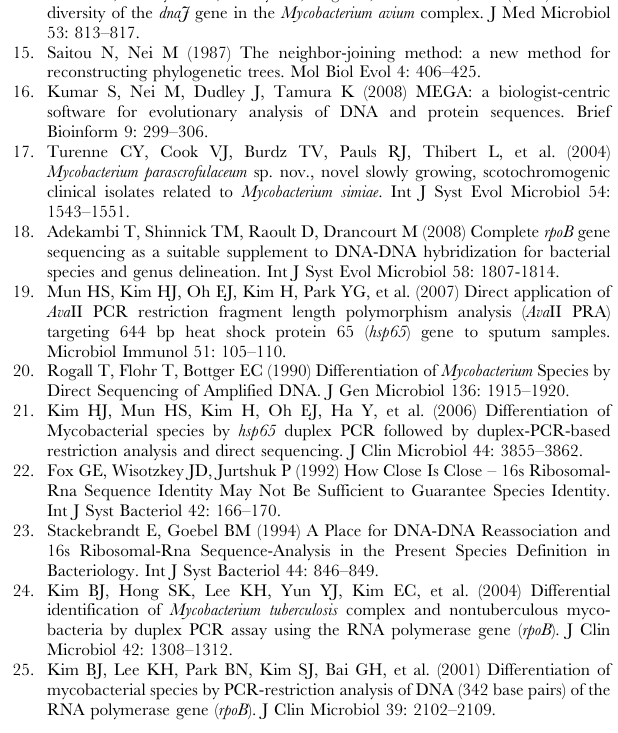
Figure S1 Locations of primers used for amplification of the full rpoB ( 3450 bp ) gene sequence in this study. Table S1 Mycobacteria strains used in this study. Table S2 The primer sets used for amplification of the